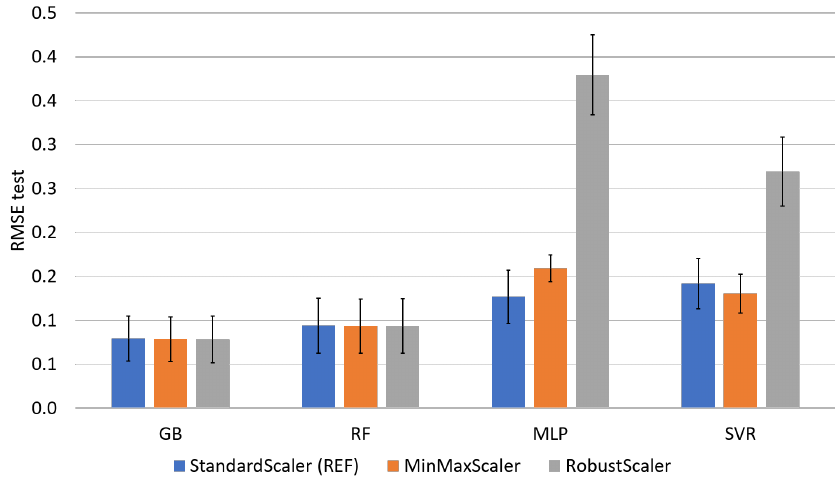
Figure E2. Scaler impact on test RMSE, without HP optimization.